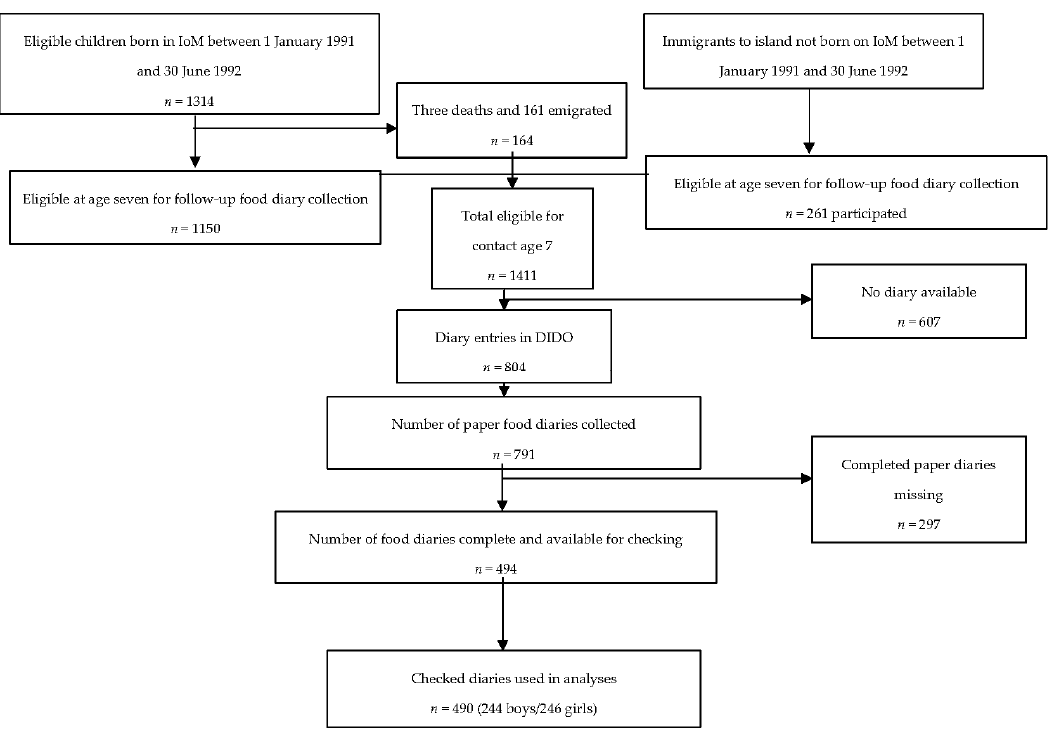
Figure 1. Flowchart showing how final study numbers for data analysis were obtained.